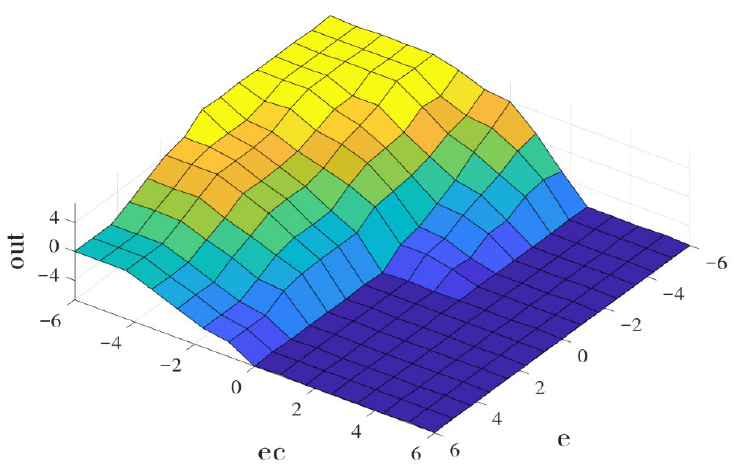
Figure 6. Fuzzy output v ( k ) subordinate degree function.